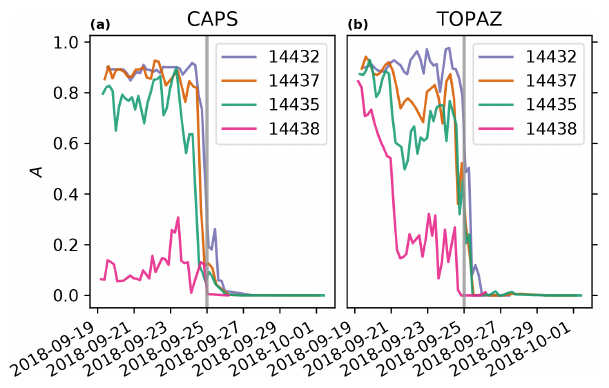
Figure 2. Ice concentration interpolated to drifter tracks as calcu- lated by (a) CAPS and (b) TOPAZ. The vertical grey line shows the approximate time (25 September 2018, 00:00UTC) that the drifters leave the